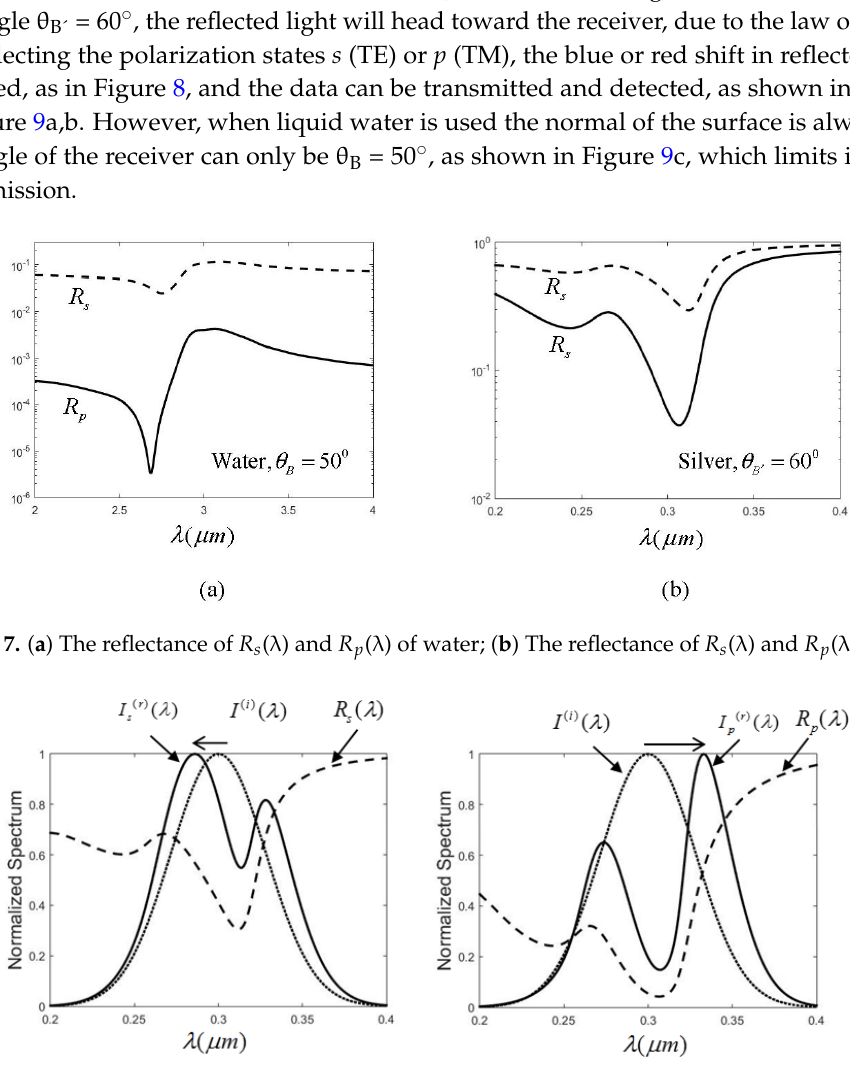
Figure 8. ( a ) Normalized spectrum for I s ( r ) (λ); (solid line), I ( i ) (λ) (dotted line) and R s (λ) (dashed line); ( b ) Normalized spectrum for I p ( r ) (λ); (solid line), I ( i ) (λ) (dotted line) and R s (λ) (dashed line). The shift of the spectrum maximum in ( a ) and ( b ) are blue-shift and red-shift respectively, as indicated by the arrows on the top of the figure.